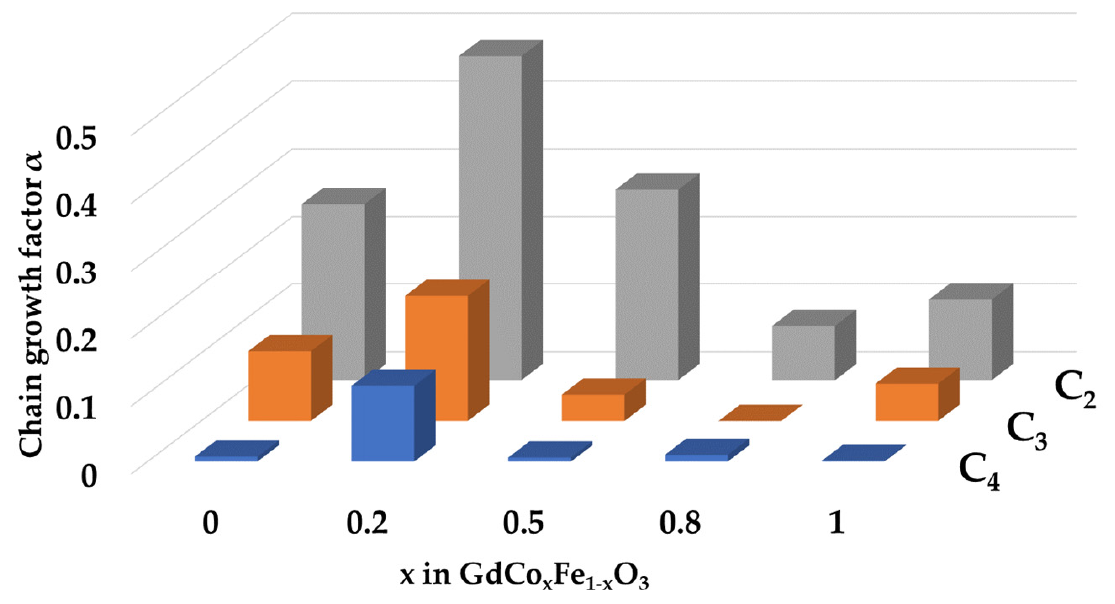
Figure 8. Chain growth factors α i at 673K for i = 2, 3, 4 over GdCo x Fe 1-x O 3 catalysts.